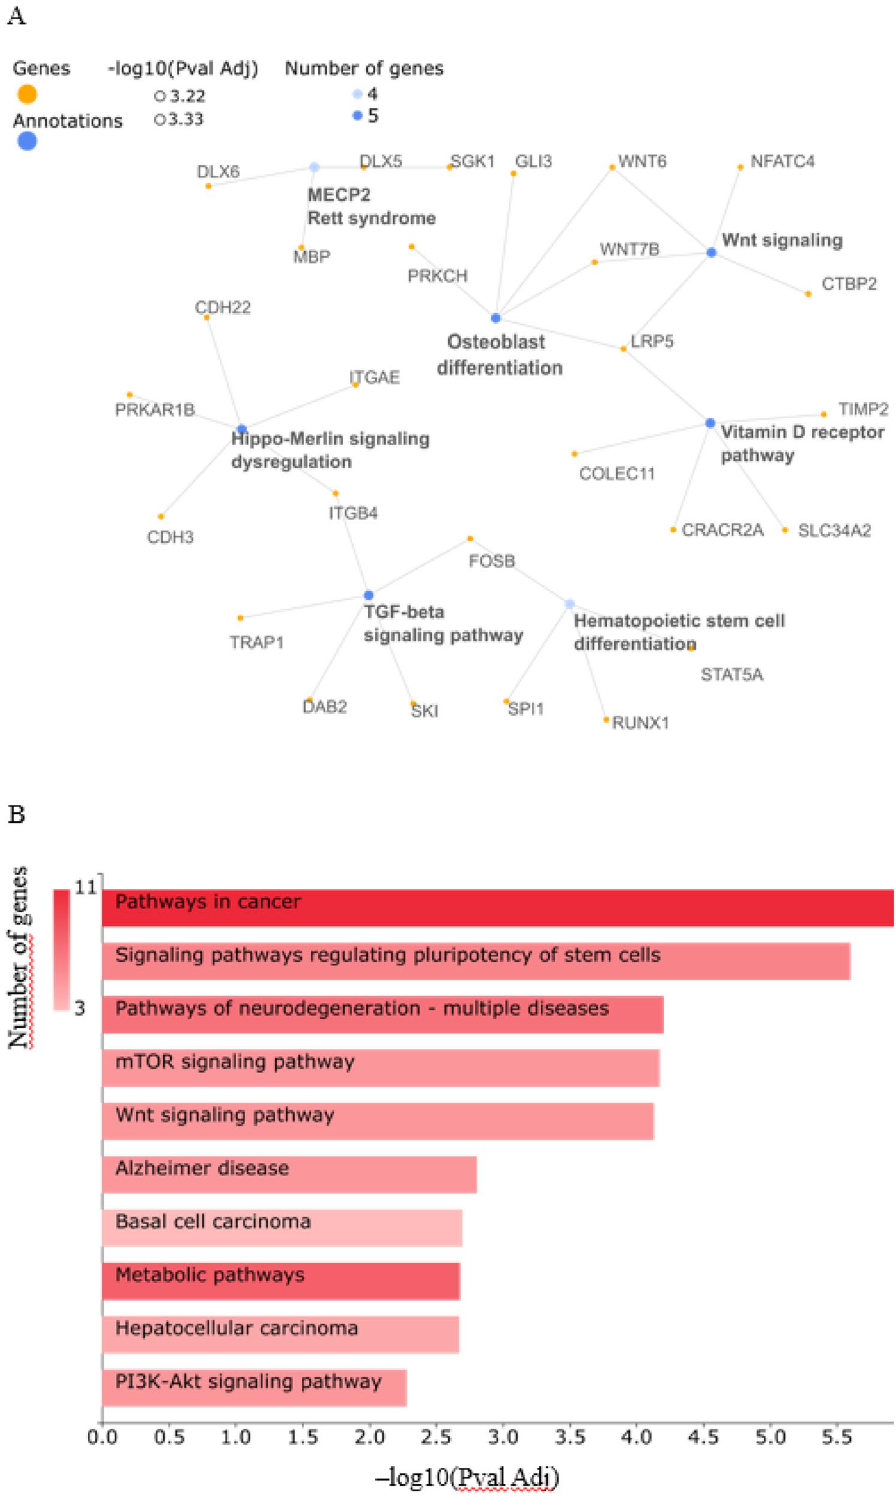
Figure 2. Main regulated pathways related to genes with differentially hypermethylated probes found in the vitamin D and high physical activity group. ( A ) Top 7 significant regulated pathways obtained with Wikipathways in GeneCodis, adjusted P value < 0.05. ( B ) Top 10 significant regulated pathways obtained with KEGG, adjusted P value <